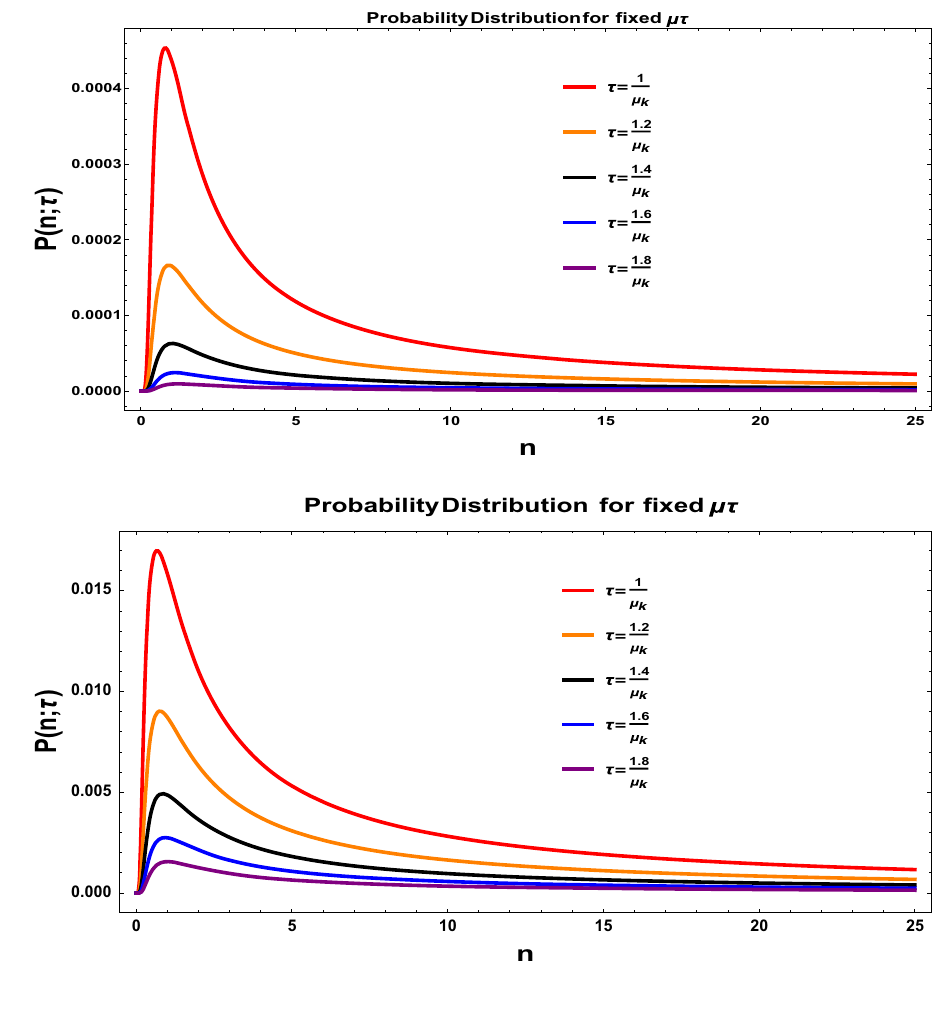
Fig. 56 Evolution of the probability density function for Stratonovitch prescription with respect to the occupation number per mode n , for a